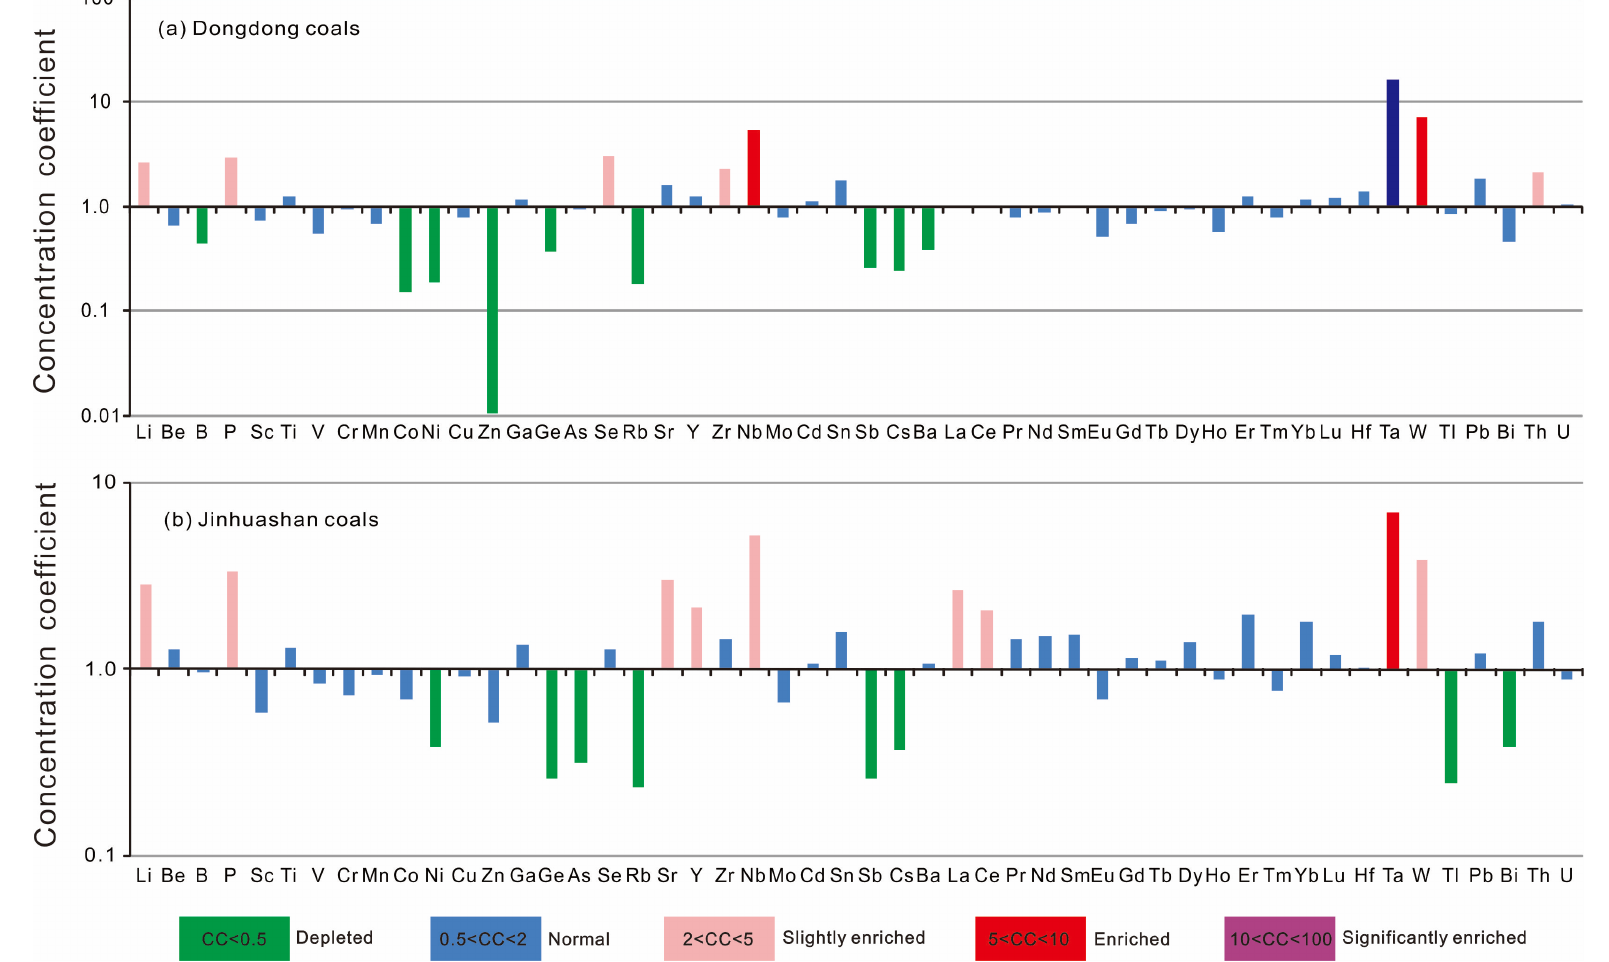
Figure 5. Concentration coefficients (CC) of trace elements in the coals from the Dongdong and Jinhuashan Coals. Normalized to average trace element concentration forworldwide coals [37]. ( a ) CC of trace elements in the Dongdong Coals; ( b ) CC of trace elements in the Jinhuashan Coals